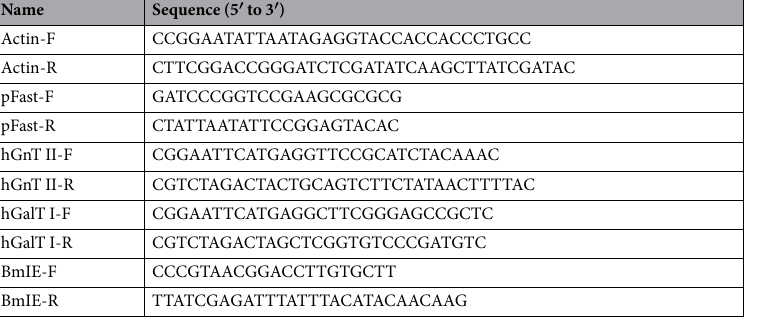
Table 1. Primers used in this